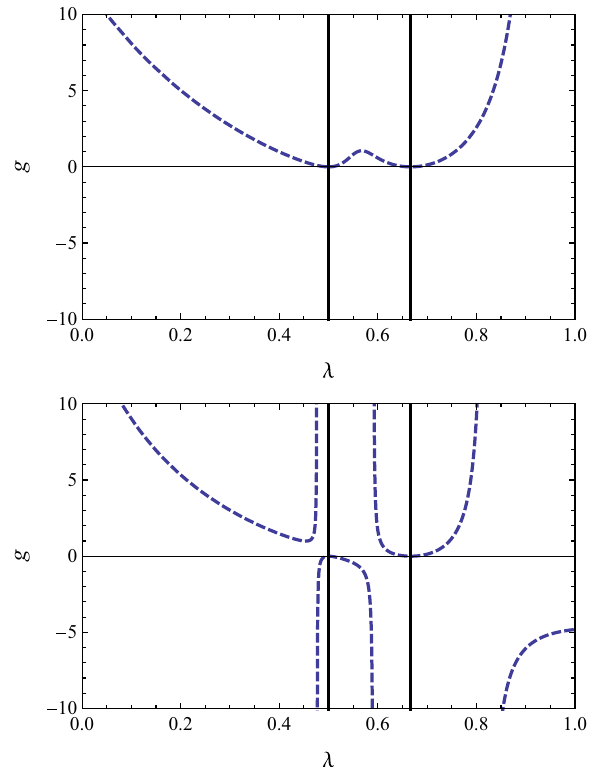
Fig. 1 Singular loci of the beta functions (31) for the Type I, linear ( left ) and Type II 0 , linear ( right ) setup in d = 3. The black , solid lines show the fixed singularities (37) while the divergence of η is given by the dashed blue line . The two diagrams illustrate the two prototypical cases where the fixed singularity is screened ( left ) or unscreened ( right ) by η